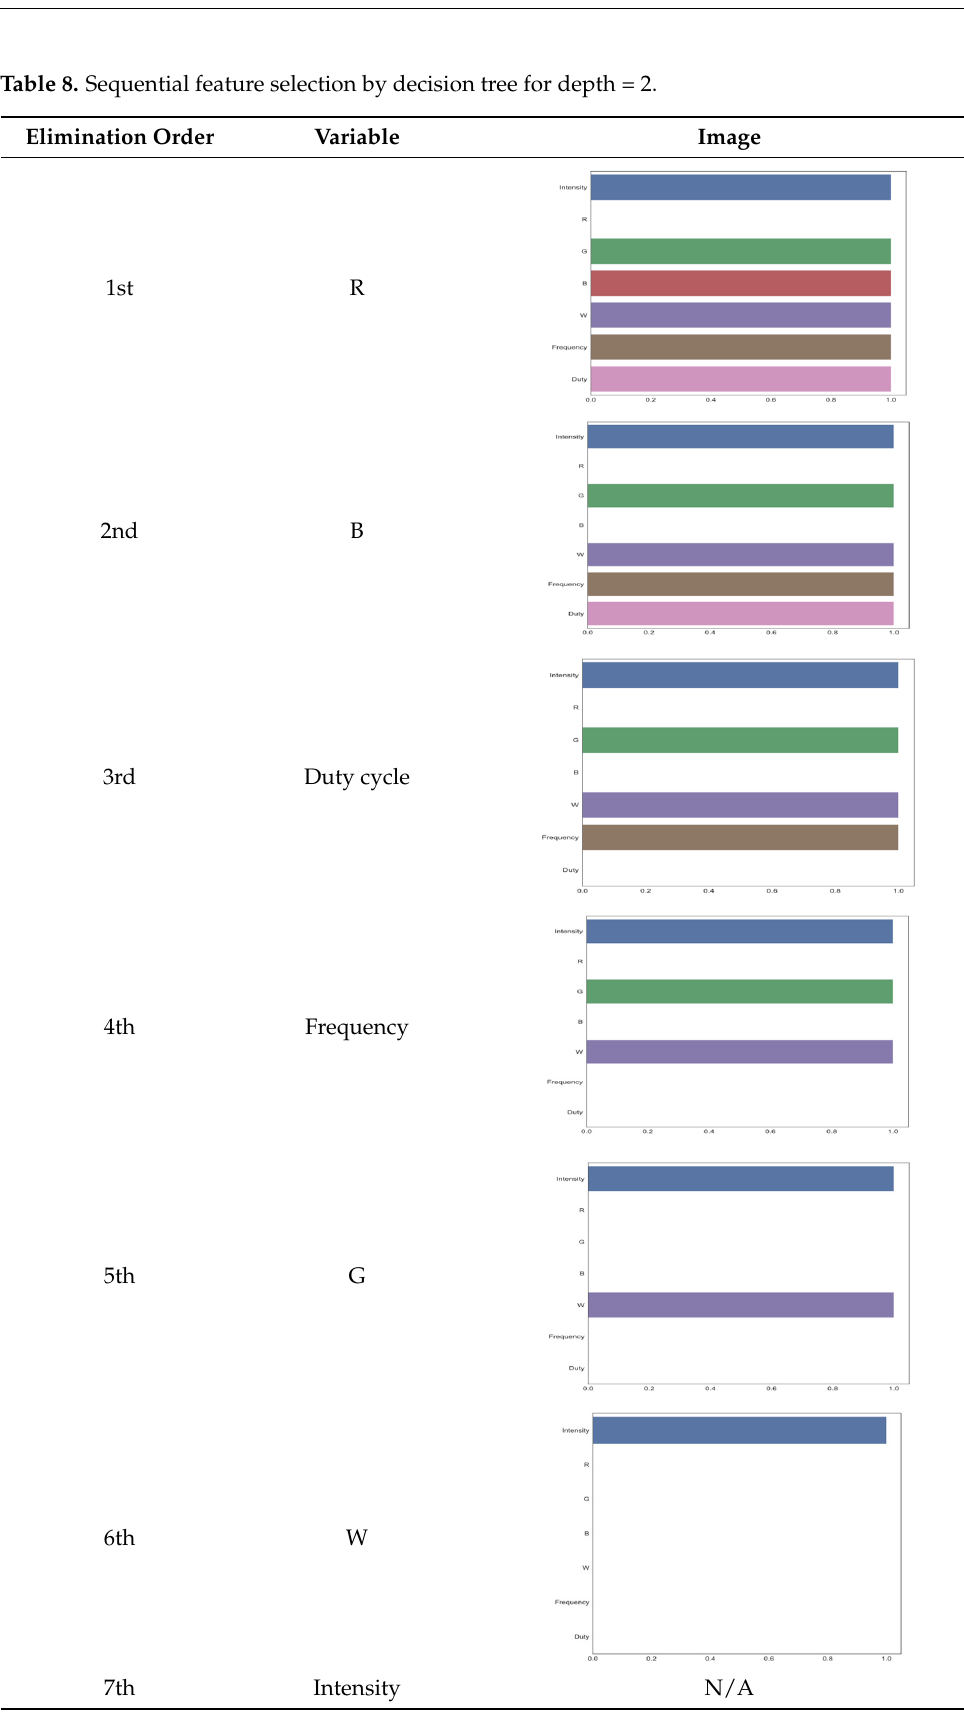
Table 9. Sequential feature selection by decision tree for depth = 3.